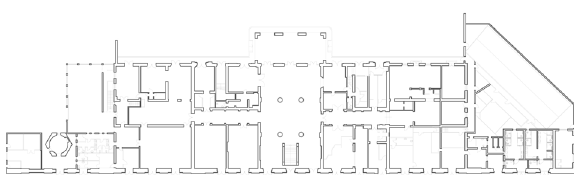
Figure 2. Planimetry of Fontivegge Station.